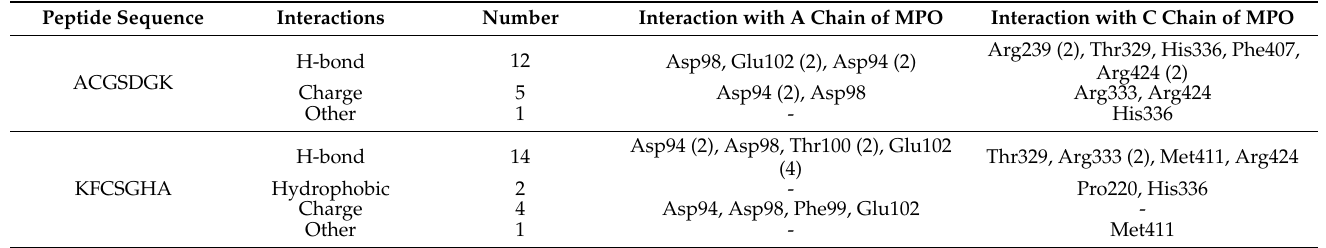
Table 3. Amino acid residues involved in the interactions between bioactive peptides and MPO from predicted binding